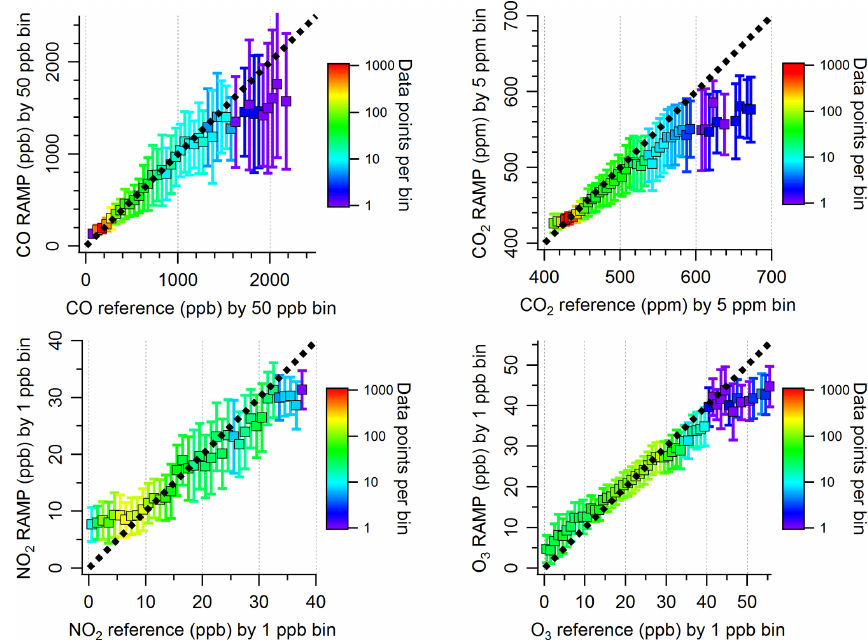
Figure 11. Illustrating the range of predictions from the 500 trees for RAMP #1. The testing data were binned and averaged. The concentra- tion measured by the calibrated RAMP monitors is then plotted against the average concentration from the reference monitor. The error bars represent the standard deviation of the answers from the 500 trees, and the bins are color-coded by the number of data points within each bin. The dashed black line is the 1 : 1